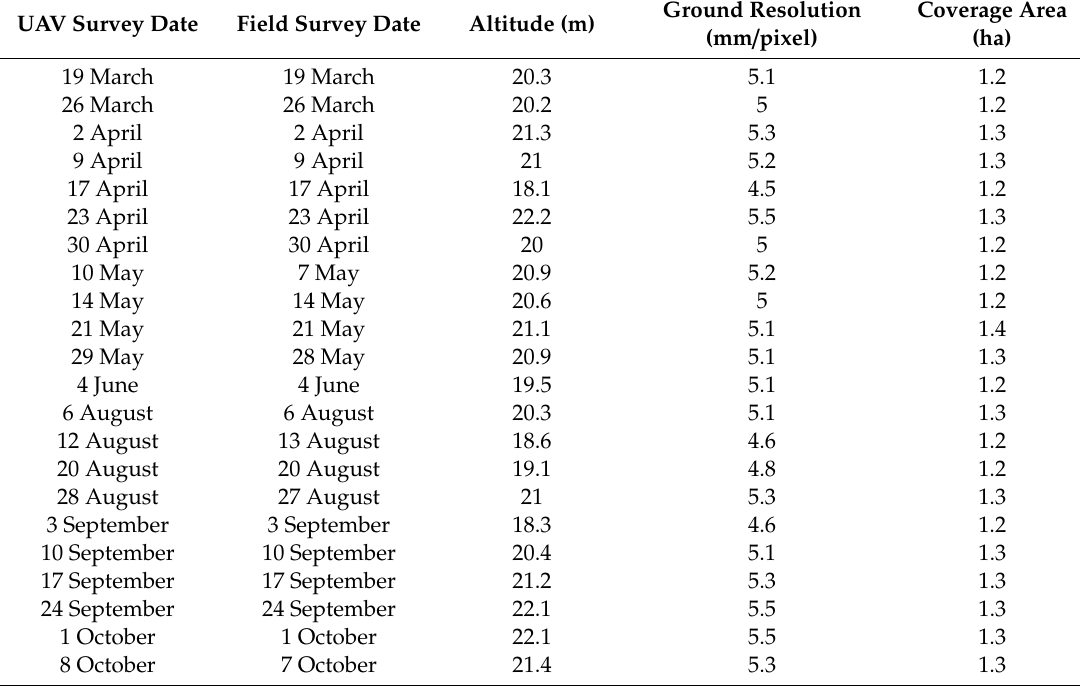
Table 1. List of UAV flights in two crop